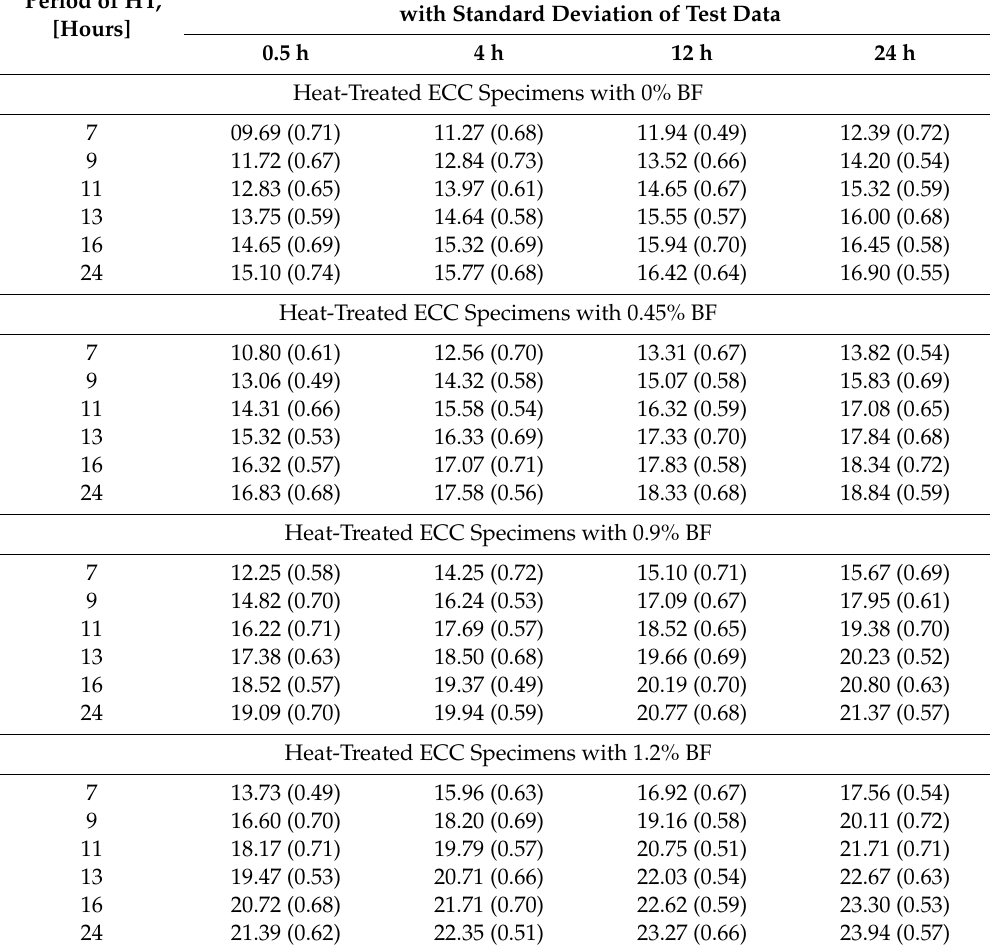
Table 6. Results of laboratory tests of heat-treated ECC specimens on compressive strength. Period of